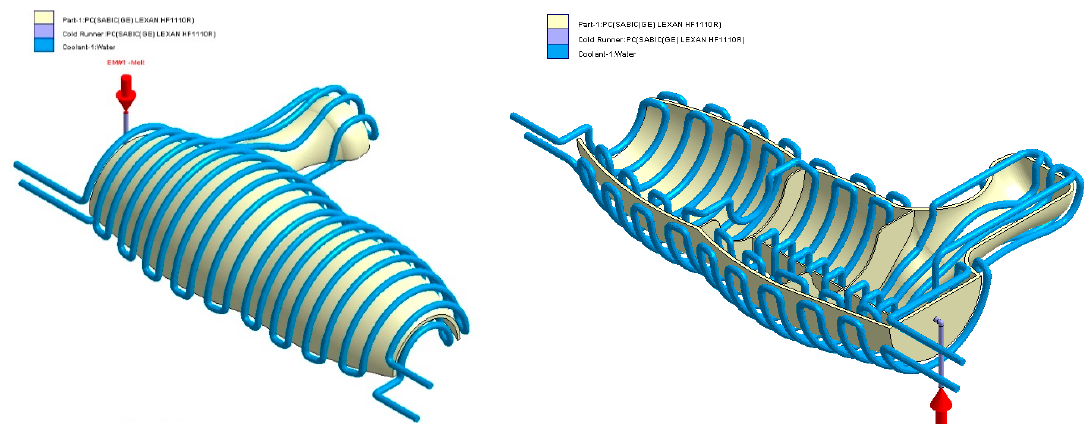
Figure 21. Cooling system design, Case B. Front view ( left ) and bottom view ( right ).